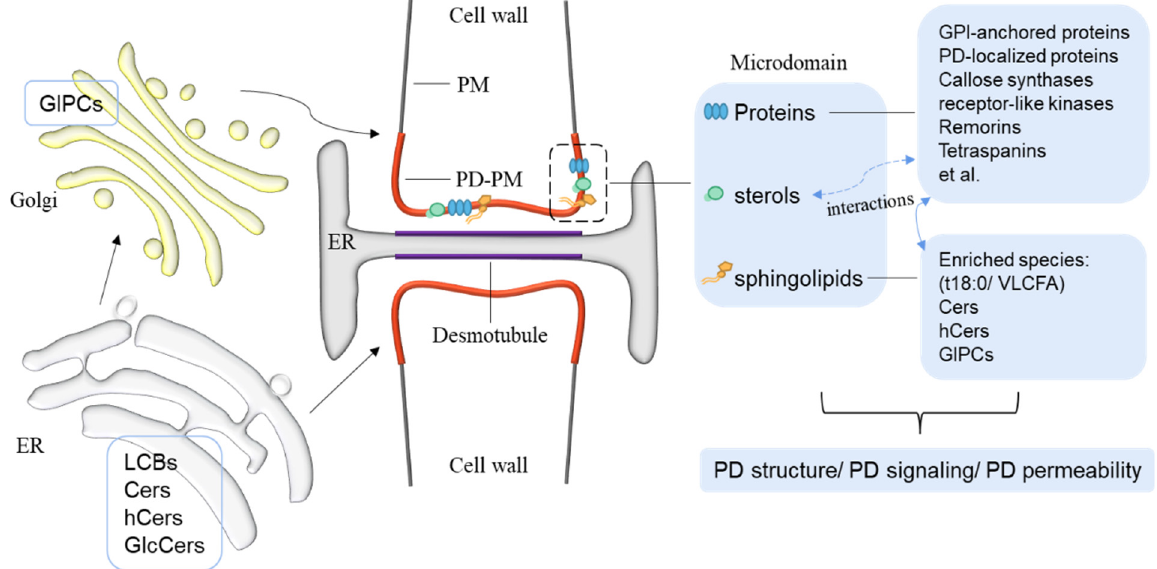
Figure 2. A schematic diagram of plasmodesmata architecture and components. LCBs, Cers, hCers, and GlcCers are synthesized at the ER and transported to the Golgi, where GIPCs are produced. These sphingolipid species can be sorted and transported to their destination, including the PM and PD-PM. Specific proteins, sterols, and sphingolipids, especially the t18:0/VLCFA-contained sphingolipids, are enriched in the microdomains formed at the PD-PM (red segment). They may function by interacting with each other to regulate the PD structure, signaling, or permeability, such as the experimentally verified binding of PD-LOCATED PROTEIN 5 to phytosphinganine (t18:0) [44] and potential interactions between tetraspanins and sterols [45]. The composition of the special membrane of the desmotubule (purple segment) derived from the ER is still elusive. LCBs, long-chain bases. Cers, ceramides. hCers, hydroxyceramides. GlcCers, glucosylceramides. IPCs, inositolphosphoceramides. GIPCs, glycosylinositolphosphoceramides. ER, endoplasmic reticulum. PD, plasmodesmata. PM, plasma membrane. VLCFA, very-long-chain fatty acid.